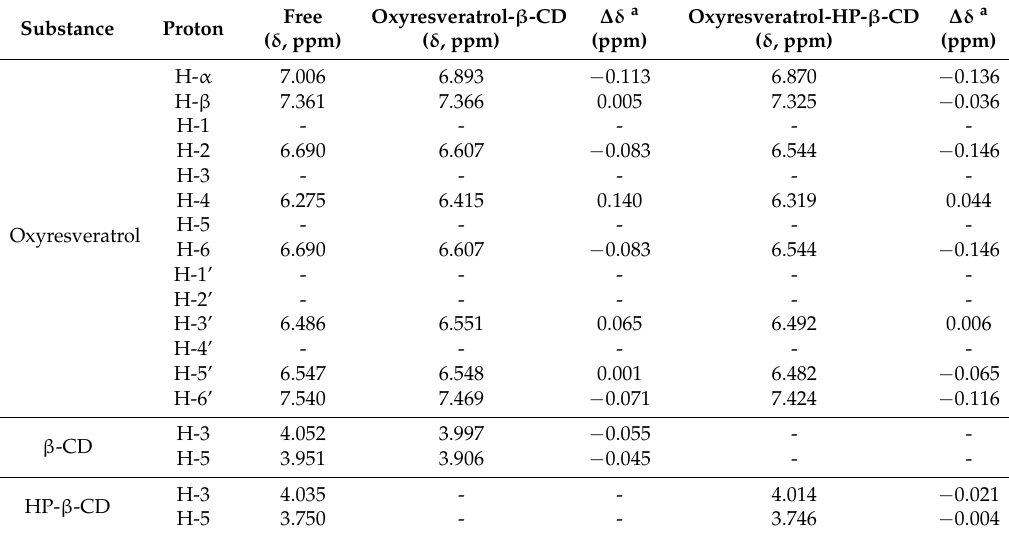
Figure 4. 1 H-NMR spectra of oxyresveratrol ( a ); β -CD ( b ); oxyresveratrol- β -CD inclusion complex ( c ) in D 2 O ( A ); 1 H-NMR spectra of oxyresveratrol ( a ); HP- β -CD ( b ); oxyresveratrol-HP- β -CD inclusion complex ( c ) in D 2 O ( B ). Table 2. Variation of the 1 H chemical shift ( δ , ppm) of oxyresveratrol and β -CD as well as HP- β -CD protons in free and complex states.